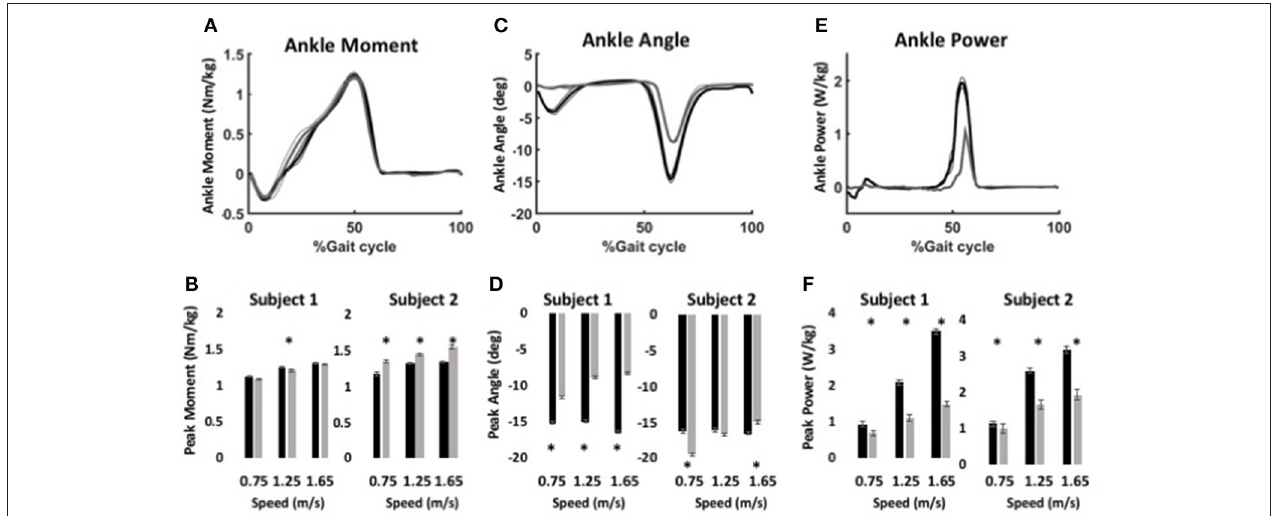
FIGURE 5 | Ankle kinematics and kinetics during level walking at variable speed using WFH (gray) and BiOM stock (black) controllers. (A) Average ankle moment (Nm/kg) ± SEM vs. % gait cycle. (B) Peak ankle moment (Nm/kg) ± SEM for two subjects at three walking speeds. (C) Average plantarflexion angle (degrees) ± SEM vs. % gait cycle. (D) Peak plantarflexion angle (degrees) ± SEM for two subjects at three walking speeds. (E) Average ankle power (W/kg) ± SEM vs. % gait cycle. (F) Peak ankle power (W/kg) ± SEM for two subjects at three walking speeds. Data in (A,C,E) are from for Subject 1 walking at 1.25 m/s. Asterisks (*) represent statistical differences ( P < 0.05) using Steel-Dwass non-parametric tests.